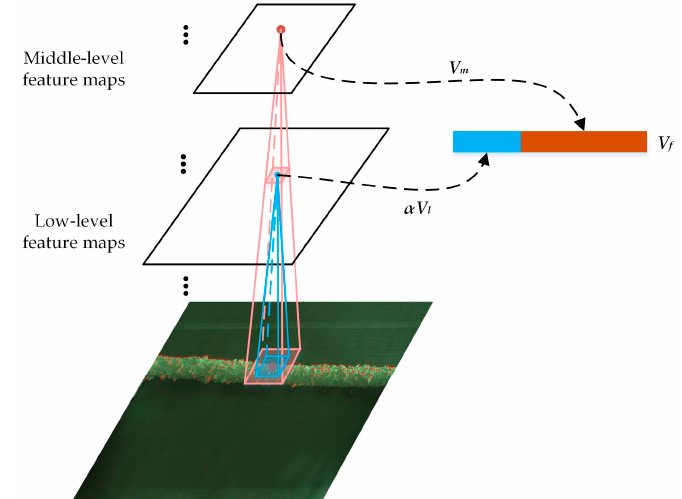
Figure 3. Illustration of multi-layer features fusion.3.3. Feature Matching.